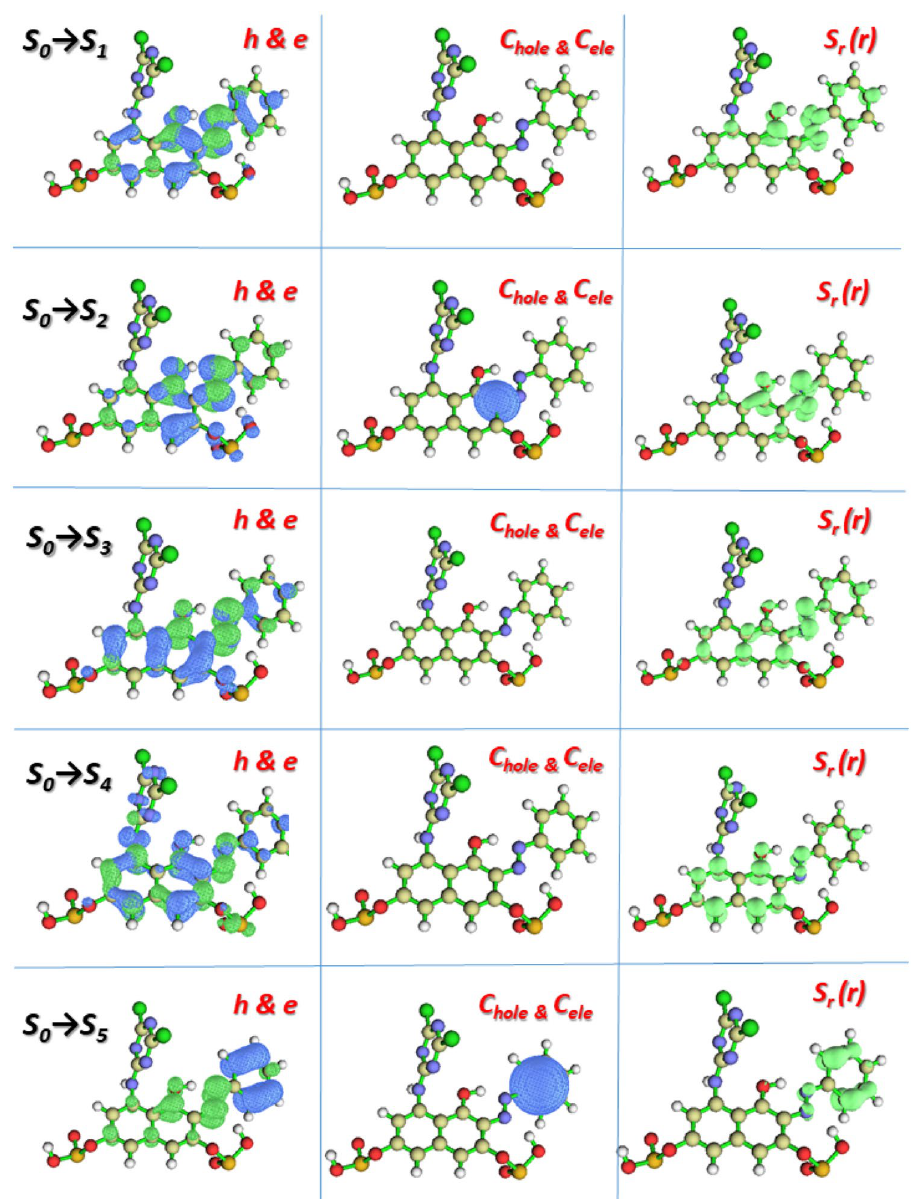
Fig. 5 Visualized hole and electron, hole and electron centroids, and Sr isosurfaces of cyanurated H-acid with aniline (CHA) usingRB3LYP method with 6-31G (d,p) basis